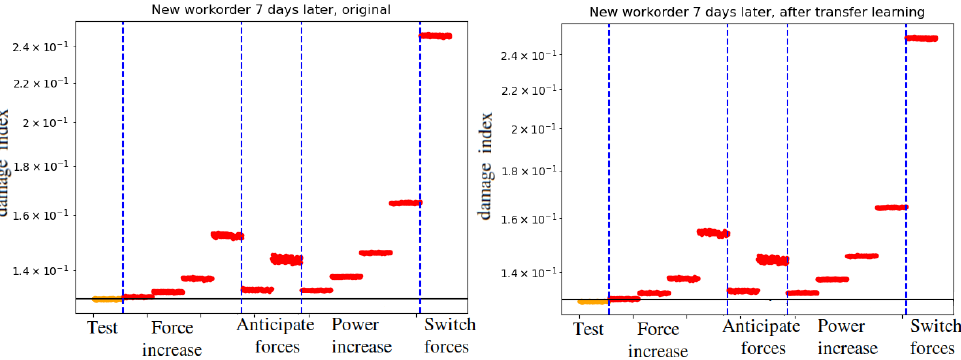
Figure 11. Damage indexes of correct and failure test data before ( left ) and after transfer learning ( right ) using 2D-CNN-AE model in data of same die one week later. Correct damage indexes are represented in orange and failure damage indexes in red. Horizontal black line represents the anomaly detection threshold and dashed blue line splits data by each failure type. In addition, each failure type contains all its magnitude versions stacked one after another incrementally, causing a staircase-like behaviour given that higher failure magnitudes result in higher damage